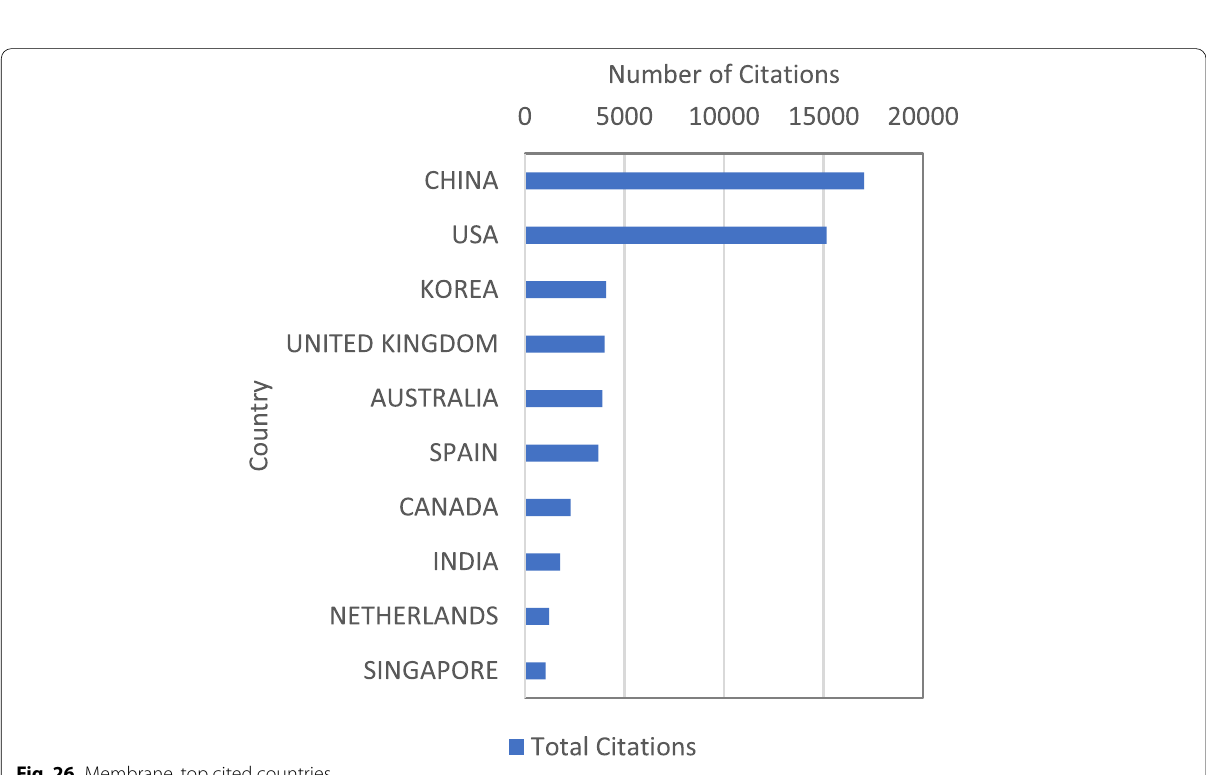
Fig. 26 Membrane, top cited